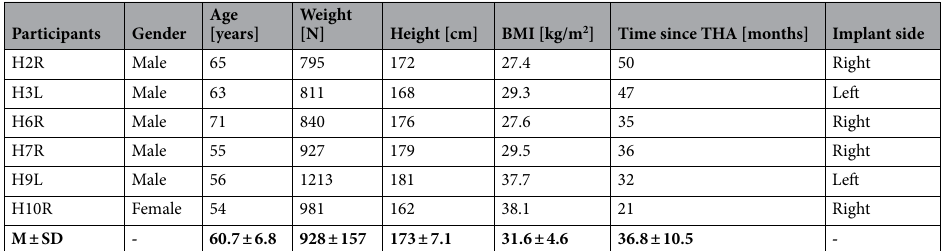
Table 1. Patients participated. M Mean, SD standard deviation, BMI body mass index, THA Total Hip Arthroplasty.